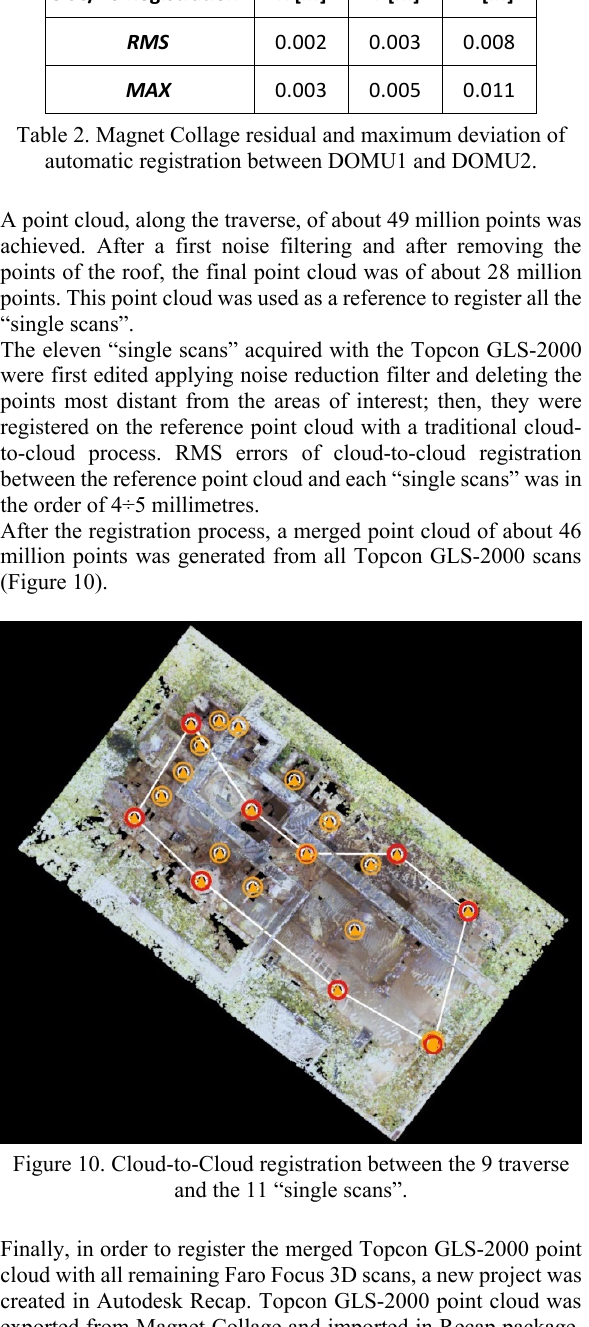
Figure 9. Magnet Collage automatic registration of scan points along the traverse